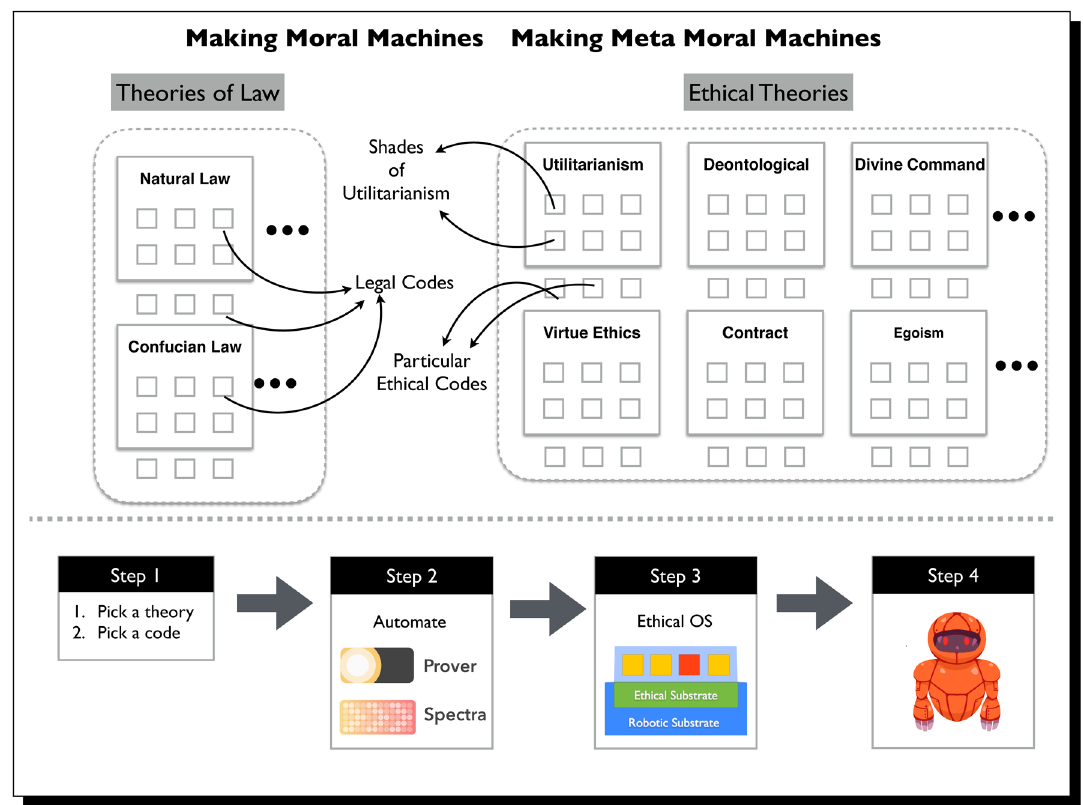
Figure 1: The four steps in making ethically correct